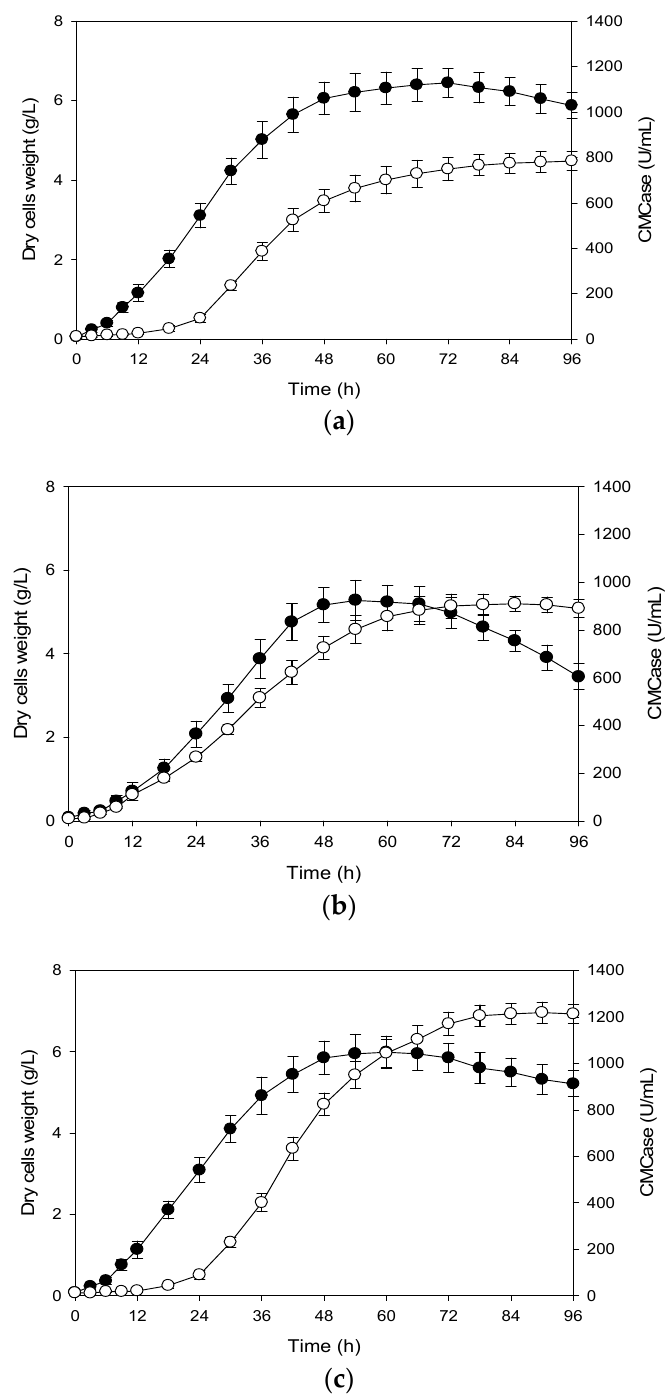
Figure 5. Comparison of cell growth and production of CMCase by E. coli KACC 91335P ( a ) under fixed optimal conditions of aeration rate and agitation speed for cell growth, ( b ) those under fixed optimal conditions of aeration rate and agitation speed for production of CMCase and ( c ) with shifts in optimal conditions of aeration rate and agitation speed from cell growth to production of CMCase at 36 h; ● , dry cells weight and ○ , CMCase.